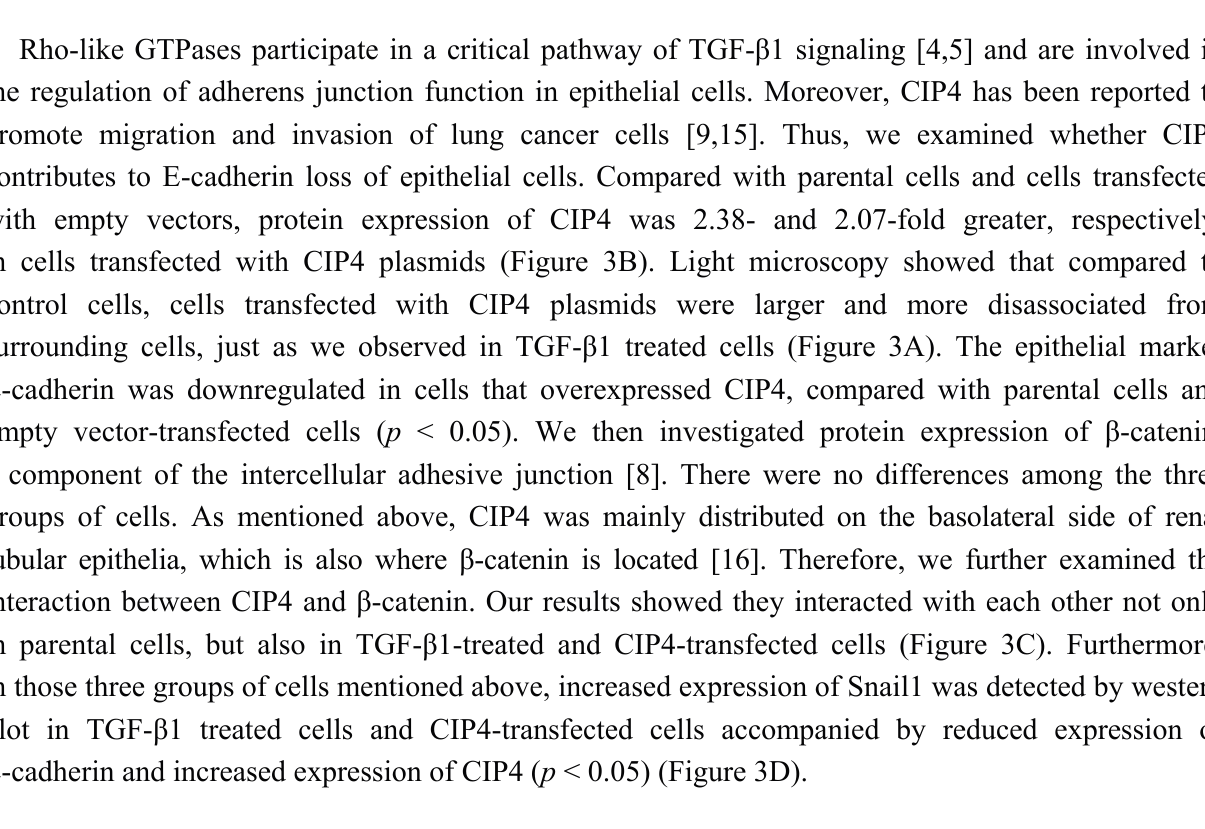
Figure 2. CIP4 is upregulated in TGF- β 1 - treated NRK-52E cells. ( A ) Phase contrast microscopy showing morphological changes in TGF- β 1 treated cells, 100×; Western blots for protein expression of ( B ) E-cadherin, β -catenin and CIP4 in whole cell lysates; and ( C ) β -catenin and CIP4 in nuclear proteins of control and TGF- β 1-treated cells. Histograms show the average volume density normalized to the loading controls GAPDH ( B ) and Lamin A/C ( C ), ( n = 3); * p < 0.05 compared with control cells. 2.3. CIP4 Interacts with β -Catenin and Overexpression of CIP4 Induces E-Cadherin Downregulation in NRK-52E